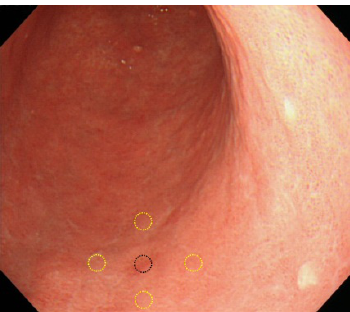
Figure 2. Assessment of color index. One central lesion and 4 surrounding points were evaluated to determine the color index. Black circle, lesion area. Yellow circles, surrounding areas.